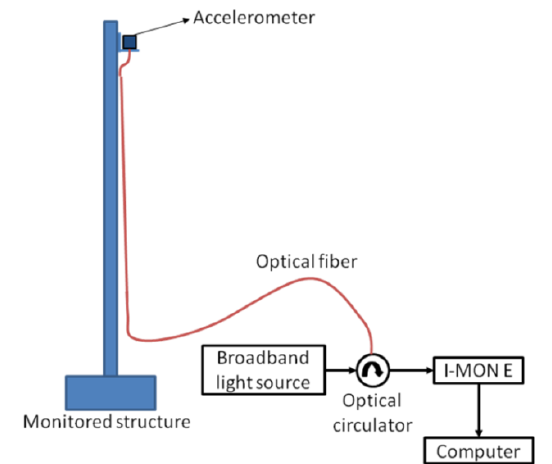
Figure 5. Scheme of the experimental setup used in dynamic monitoring